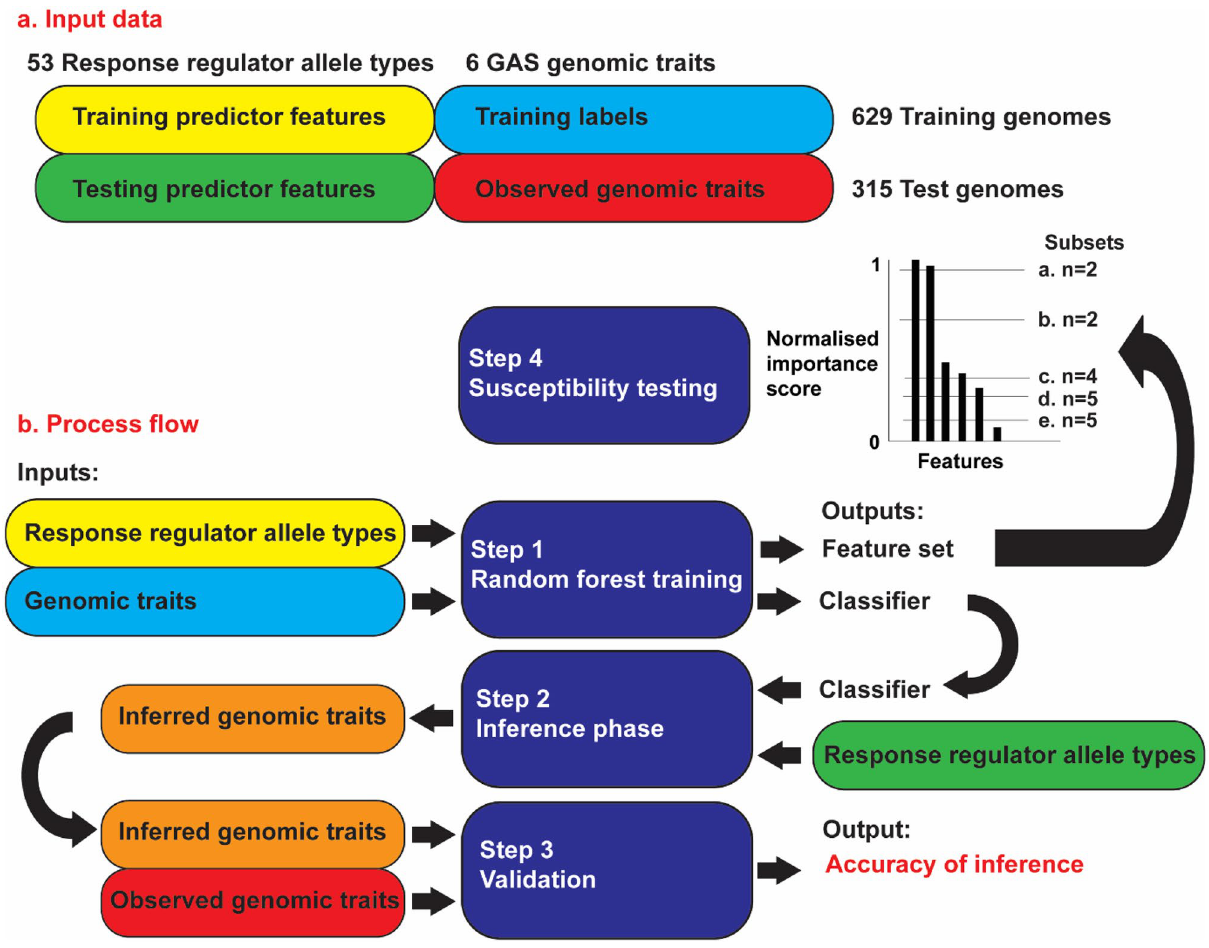
Figure 8. Summary of ( a ) input data nomenclature and ( b ) process flow of this